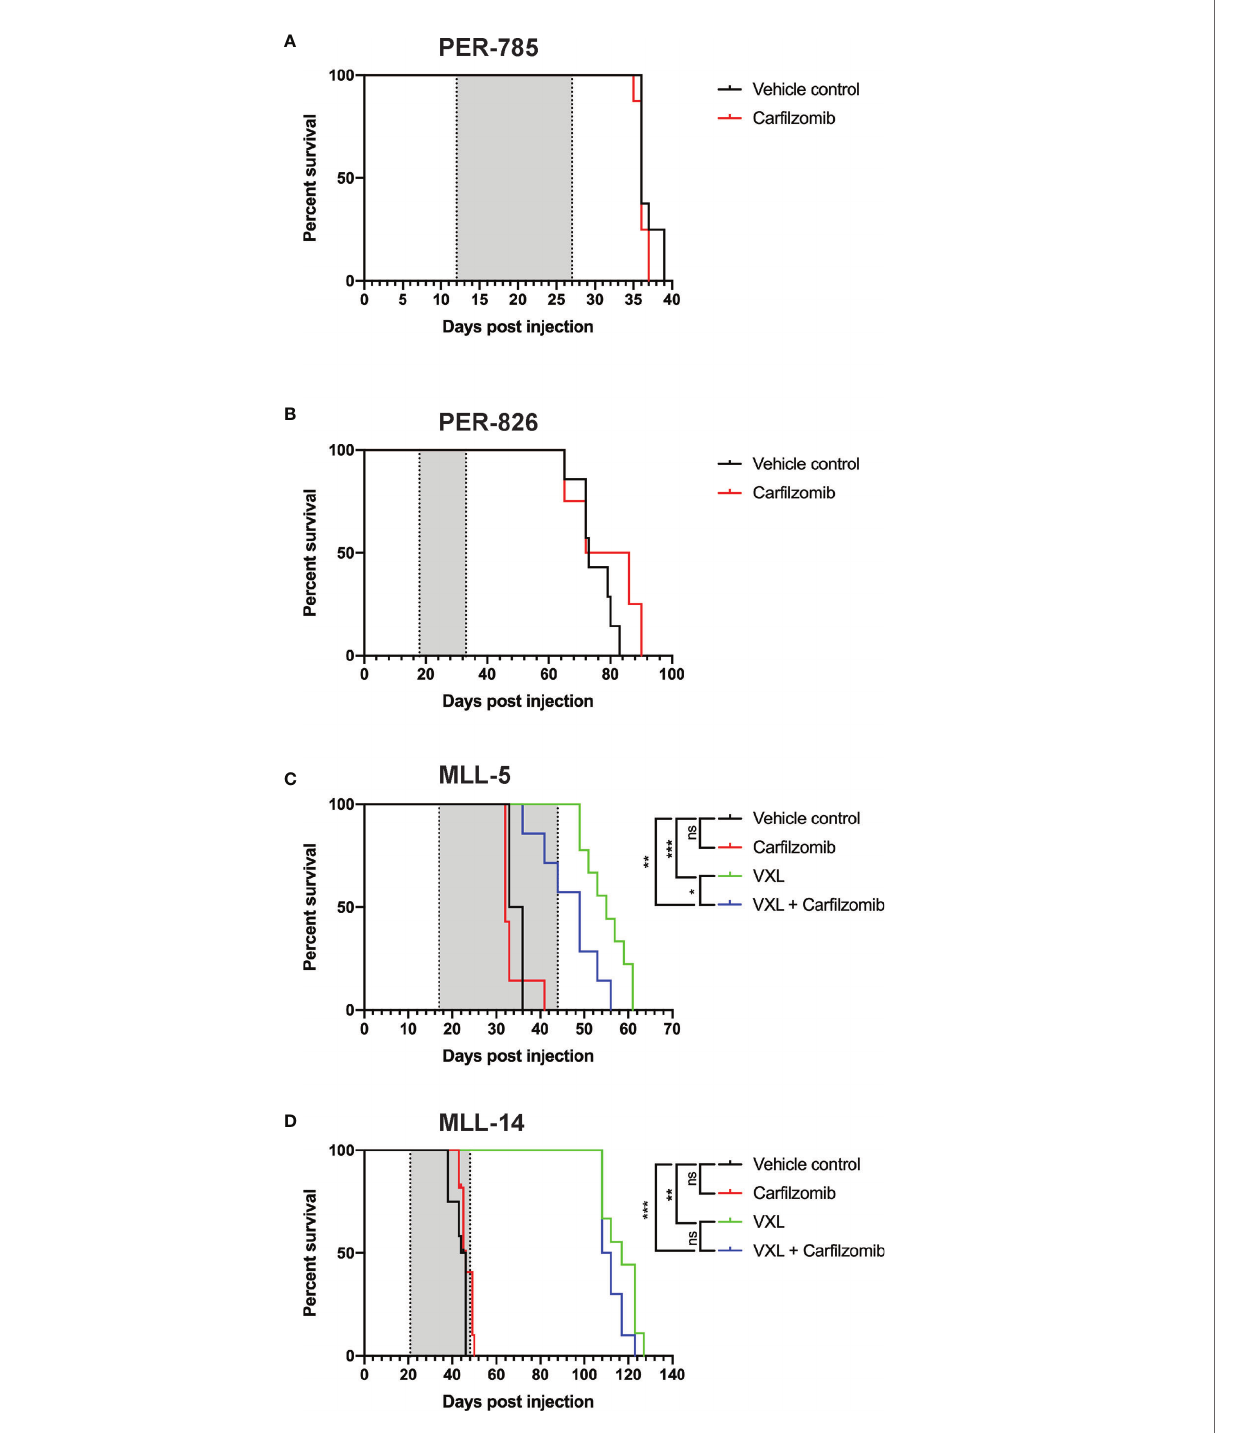
FIGURE 4 | Car fi lzomib does not extend survival in infant KMT2A -rearranged acute lymphoblastic leukemia xenografts. (A, B) Kaplan-Meier survival curves of mice injected with PER-785 or PER-826 leukemia cells that were treated at low leukemic burden with vehicle control or 2 mg/kg car fi lzomib on days 1, 2, 8, 9, 15, and 16 (n = 8 mice per group). (C, D) Kaplan-Meier survival curves of mice injected with MLL-5 or MLL-14 leukemia cells that were treated at high leukemic burden with car fi lzomib, VXL, car fi lzomib-VXL combination therapy, or vehicle control (n = 10 mice per group). Car fi lzomib was administered intravenously on days 1, 2, 8, 9, 15, and 16 at 1.5 mg/kg. VXL comprised of 0.15 mg/kg of vincristine once a week for 4 weeks, dexamethasone 5 mg/kg 5 days a week for 4 weeks, and L-asparaginase 1,000 U/kg 5 days a week for 4 weeks, administered by intraperitoneal injection. Gray shaded areas indicate treatment duration, with the fi rst dotted line representing the start of therapy and the second dotted line the end of therapy. *P < 0.05, **P < 0.001, ***P <